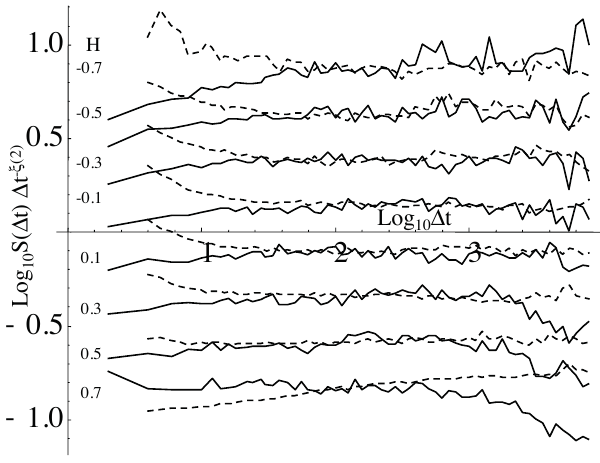
Fig. 7. This shows the compensated Haar structure functions D E 1 / 2 S Haar (1x) = 1v Haar (1x) 2 (solid lines) and the second-order MFDFA technique (dashed lines), again for H = − 7 / 10 (top) to H = 7 / 10 (bottom), every 1 / 5. Each curve was offset in the verti- cal for clarity by 1 / 4. Flat regions correspond to the theoretically predicted